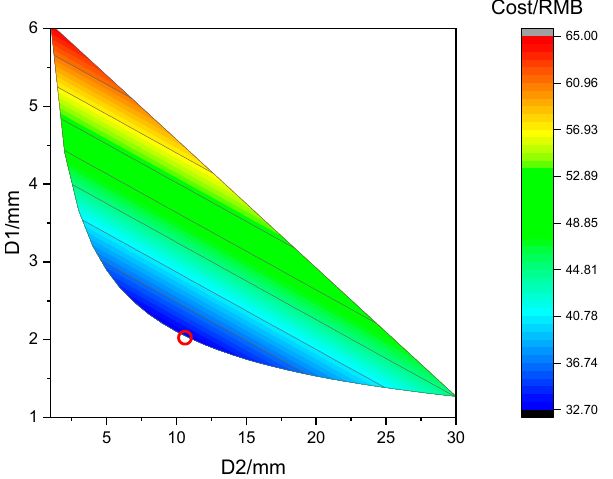
Figure 8. Cost corresponding to the parameter combination scheme.